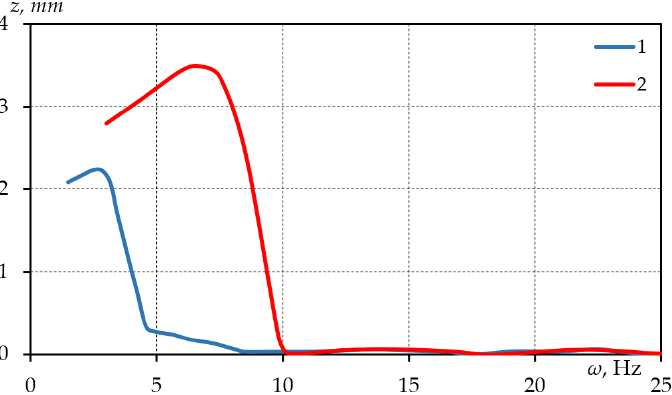
Figure 19. Comparison of vertical displacements of the vehicle body: 1 — real vehicle; 2 — suspension test bench.